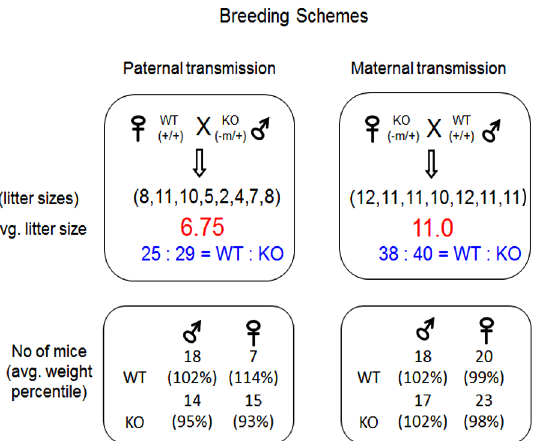
Fig 3. Mutational effects on the litter size and average body weight of the mouse. (top) Male and female heterozygotes inheriting the mutant allele maternally (-m/+) were bred with the wild-type littermates for breeding experiments. The average litter sizes and the transmission ratios of the knockin allele (WT versus KO) were summarized and presented for these two sets of breeding experiments. The numbers inside parentheses indicate the sizes of individual litters. (bottom) The average body weight in a percentile scale was also presented for each category of the pups that had been derived from the two sets of breeding